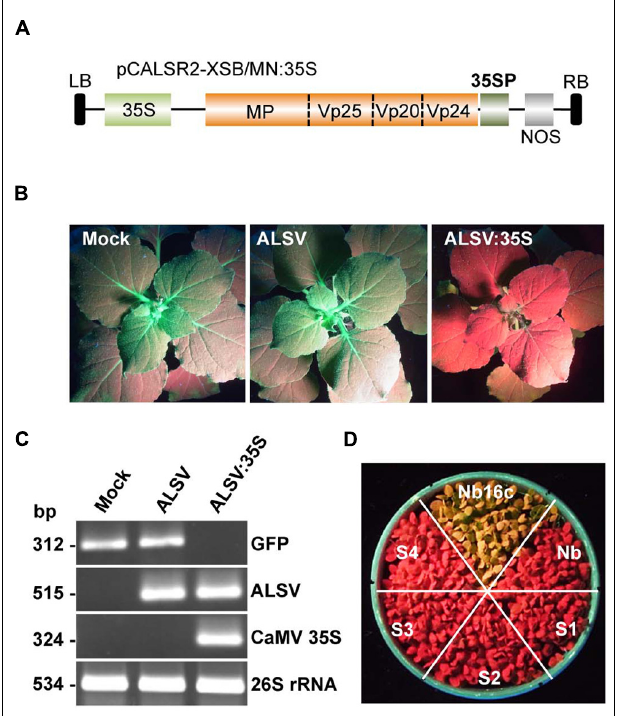
FIGURE 2 | Induction ofTGS by theALSV vector and its inheritance. (A) Schematic representation of ALSV vector containing part of the 35S promoter (35SP; pCALSR2-XSB/MN:35S). (B) N. benthamiana line 16c plants expressing GFP and mock-agroinoculated (Mock), or agroinoculated with pCALSR1 + pCALSR2-XSB (ALSV) or pCALSR1 + pCALSR2-XSB/MN:35S (ALSV:35S). Plants were photographed under UV illumination with a yellow filter.The red fluorescence reveals thatTGS of GFP occurred in ALSV:35S-infected tissues. (C) Analysis of mRNAs in agroinoculated N. benthamiana line 16c plants by RT-PCR.Total plant RNA was extracted from plants agroinoculated with empty vector (lane 1), ALSV (lane 2), or ALSV:35S (lane 3). (D) The silenced generations 1–4 (S1–S4) seedlings derived from ALSV:35S infected plants (S0), showing disappearance of GFP fluorescence.The progeny of non-transgenic N. benthamiana plants (Nb) and mock-inoculated N. benthamiana line 16c (Nb16c) are shown as